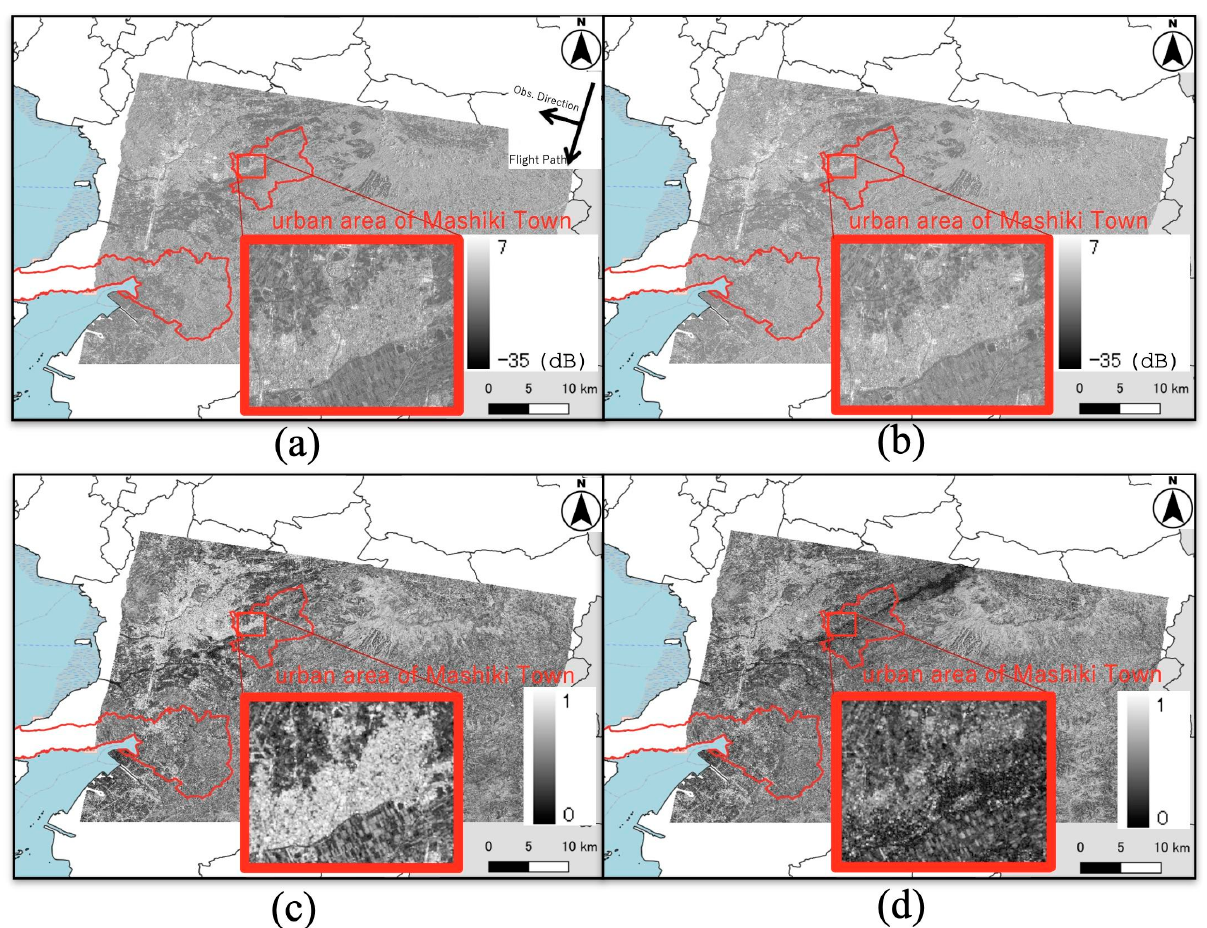
Figure 2. These are ALOS-2PALSAR-2 images of the areas affected by the Kumamoto earthquake. The areas circled in red are the study areas: ( a ) backscatter coefficient image of the 7 March 2016 pre-event; ( b ) backscatter coefficient image of the 18 April 2016 post-event; ( c ) coherence image of the 30 November 2015–7 March 2016 pre-event pair; ( d ) coherence image of the 7 March 2016–18 April 2016 co-event pair.